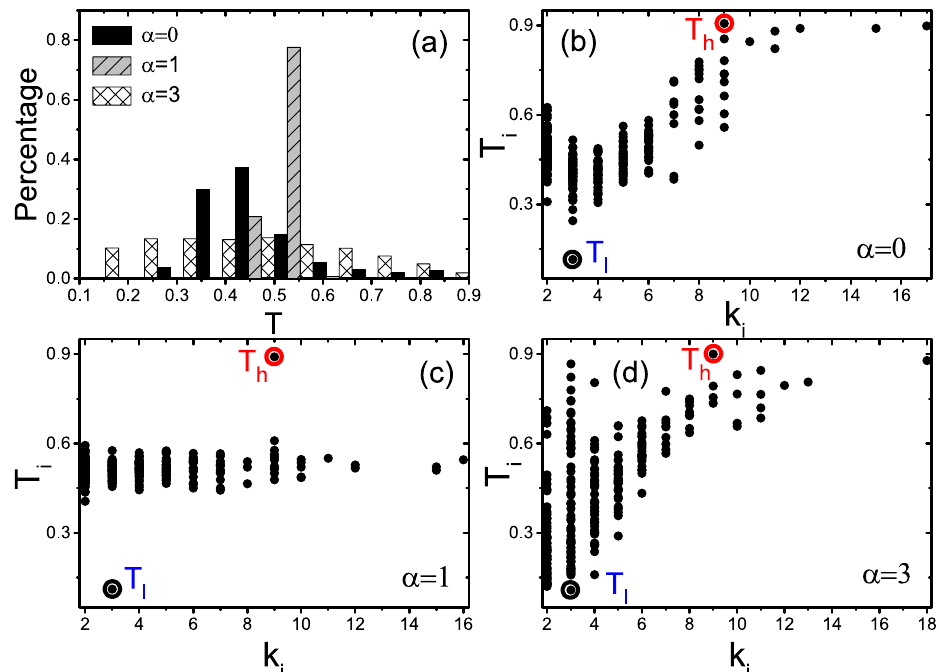
Figure 4. Influence of distributed nodes masses on the distribution of nodes temperatures for N = 300 , p = 1 and � k � = 4 , where the circles with T h and T l are the two source nodes with high and low temperatures, respectively. ( a ) Represents the distributions of nodes temperatures where the three kinds of columns represent the cases for α = 0, 1 and 3, respectively. ( b – d ) represent the dependence of node temperature T i on its degree k i for α = 0, 1 and 3,